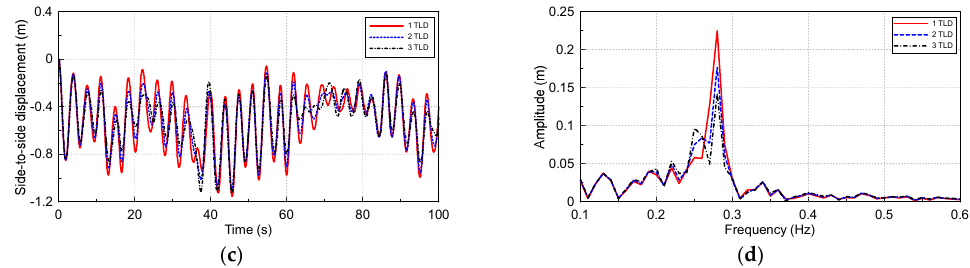
Figure 28. ( a ) and ( b ): The fore-aft displacement and corresponding amplitude spectrum of OWT with various TLDs under the DLC 1.2 condition; ( c ) and ( d ): The side-by-side displacement and corresponding amplitude spectrum of OWT with various TLDs under the DLC 6.2 condition.